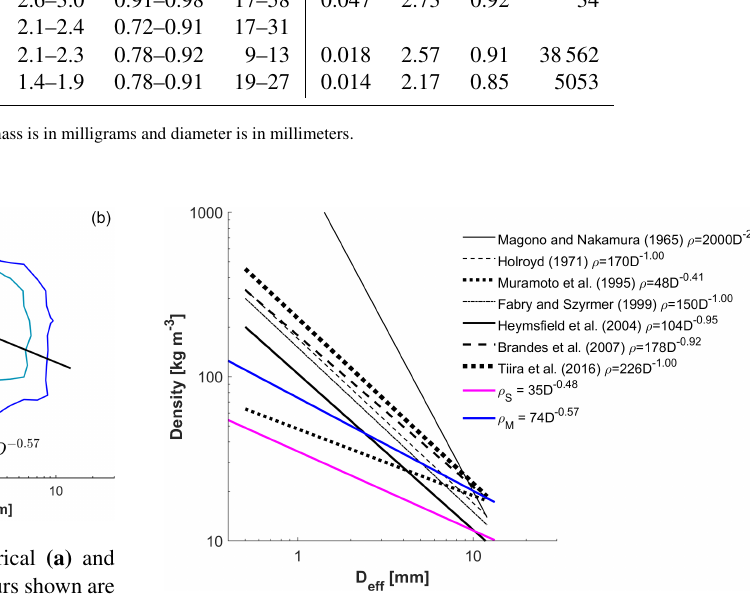
Figure 11. Density–diameter relationships from previous studies and those obtained here using the spherical density method (ma- genta) and MASC-adjusted density method